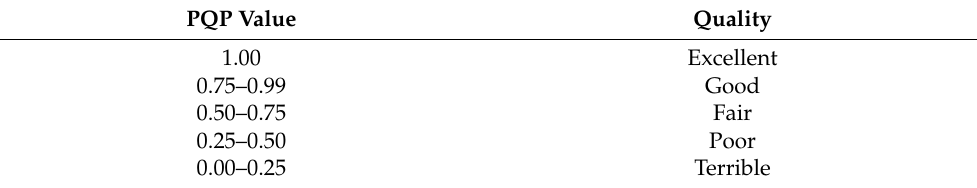
Table 4. Criteria of PQP.